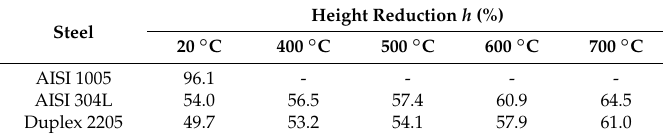
Table 2. Height reductions h at various forging temperatures.